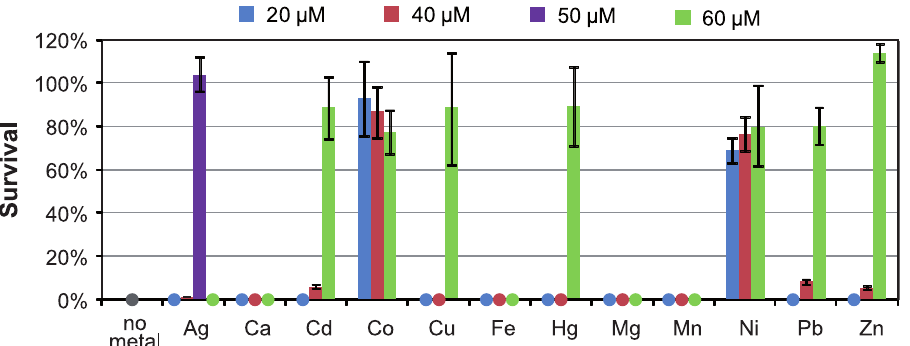
Figure 3. Effect of metals on the toxicity of 50 m M sodium selenide. Before plating on rich medium, DTY7 cells were exposed for 5 min to mixtures containing 50 m M sodium selenide and varying concentrations of the indicated metal salts. Colonies were counted after two days of growth. Shown in ordinate are the percentages of survival relative to controls performed in the absence of selenide and metal. Data of the histogram were obtained with 20 m M (blue), 40 m M (dark red), 50 m M (violet) and 60 m M (green) metal. Control experiment with no metal is in grey. Range bars at the top of the histogram bars were deduced from duplicate experiments.